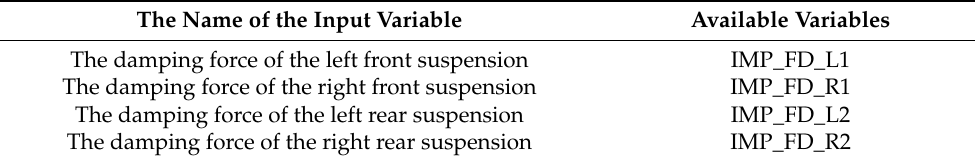
Table 3. Input variables in CarSim software.